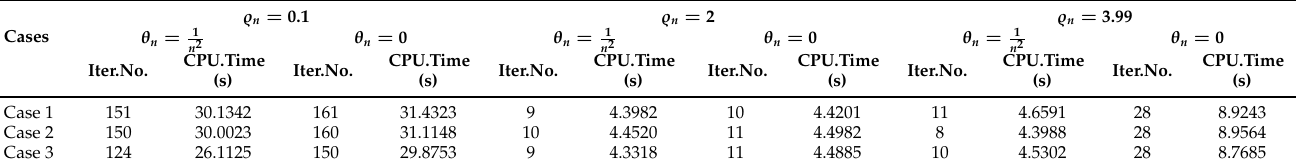
Figure 7. Cauchy error plots for the sequence { x n ( t ) } with and without the extrapolation factor ( θ n ) when (cid:36) n = 3.99. Table 1. Comparison of iteration counts and CPU times for the sequence { x n ( t ) } of Example 1 in each